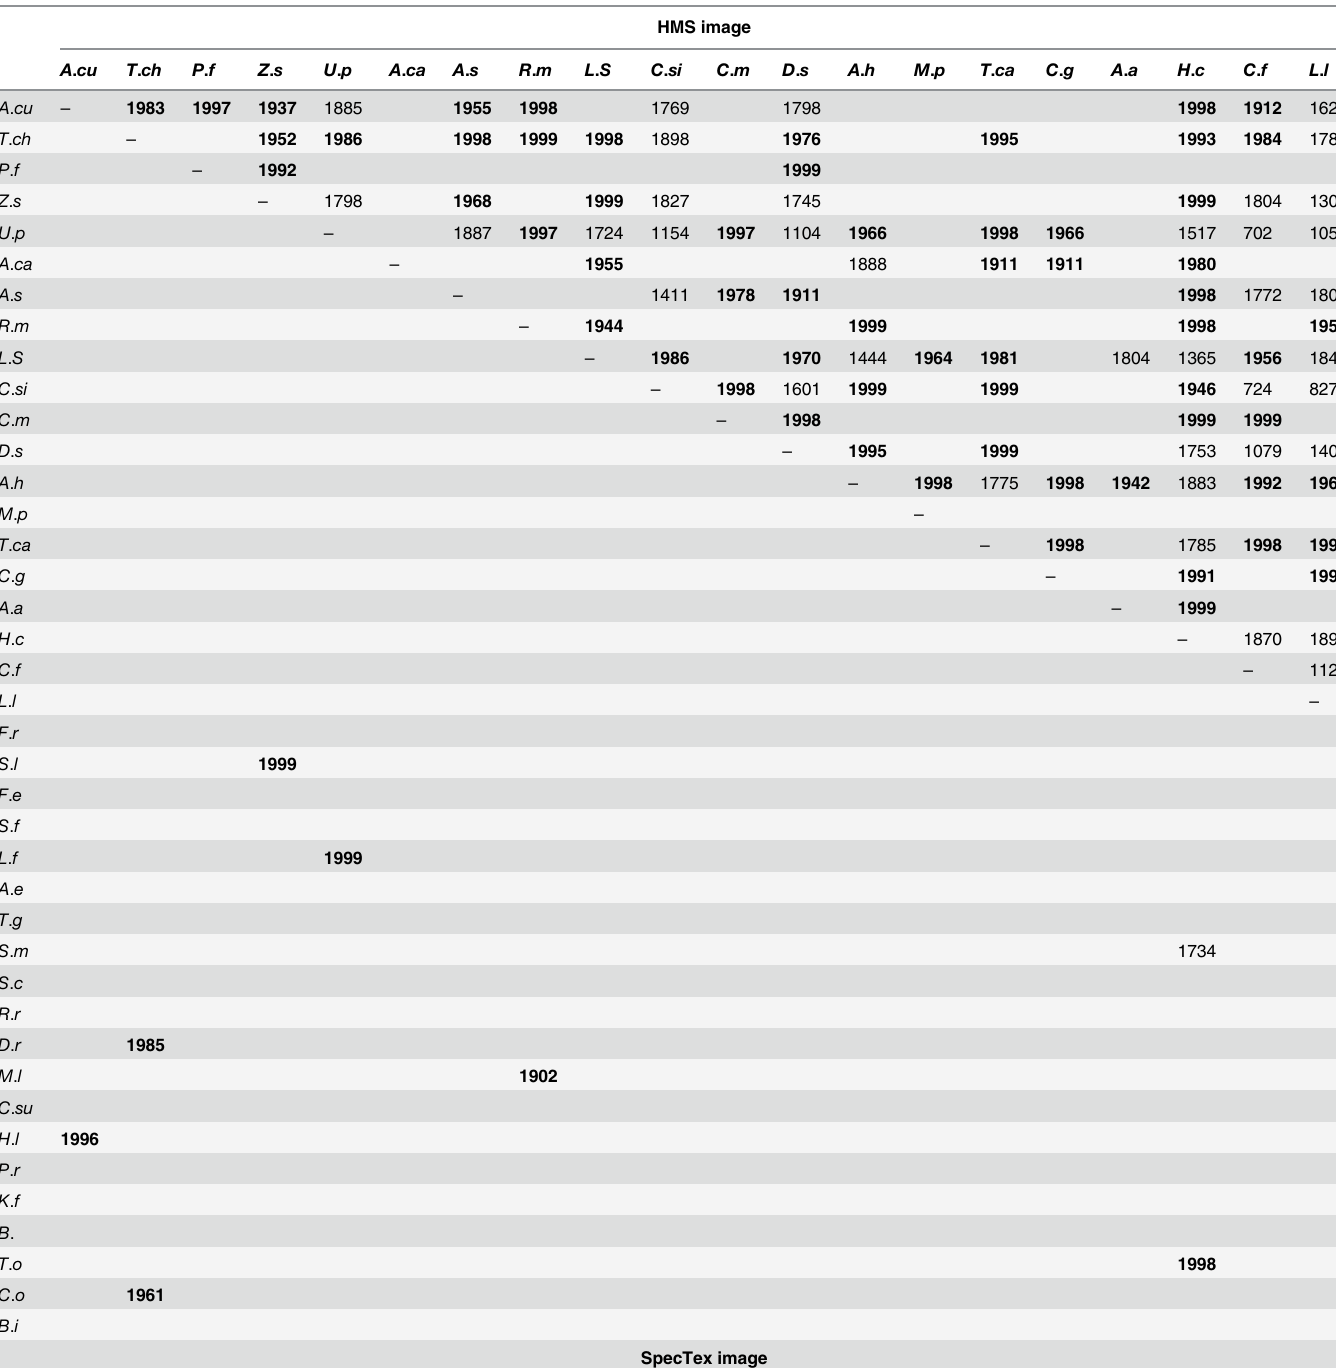
Table 3. Full-bands transformed divergences of between-species in training samples for the original spectral signatures and the spectral-spatial texture signatures. *